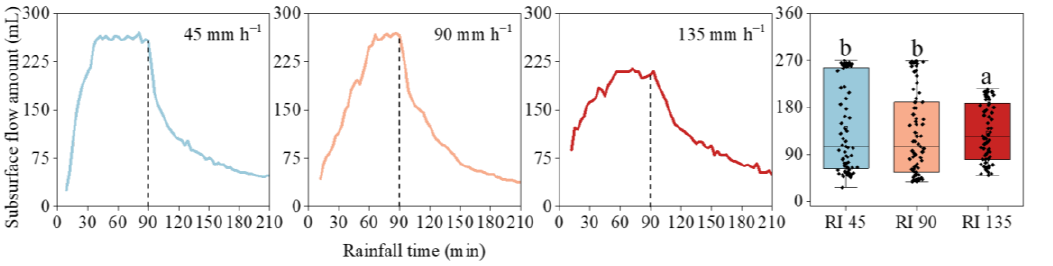
Figure 4. The subsurface flow generation processes under different rainfall intensities. Error bars represent standard errors of the means ( n = 80). Bars with different letters differ significantly.